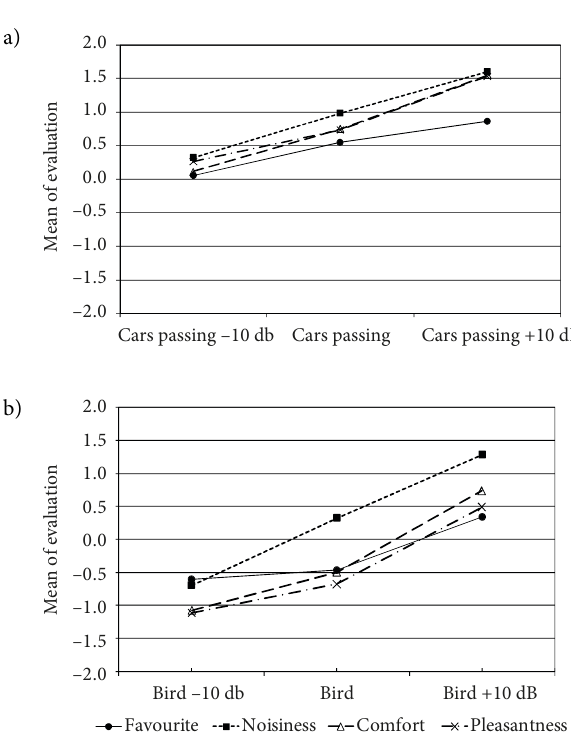
Fig. 5. Correlations between loudness and the subjective evaluations of favourite, noisiness, comfort, and pleasantness for (a) bird sound; (b) cars